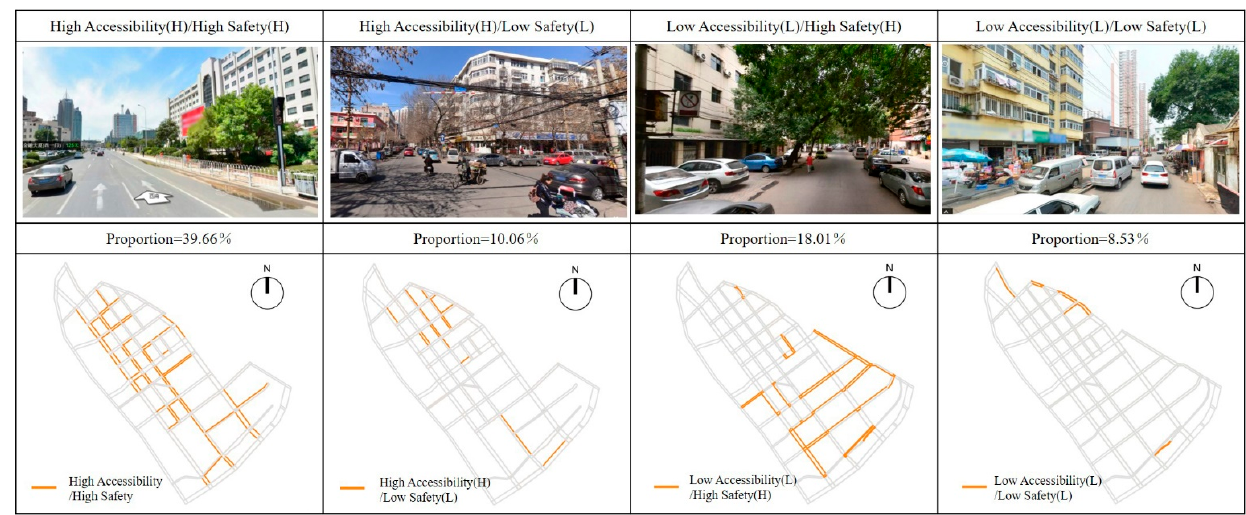
Figure 21. School Travel Routes Planning of the Study Area.